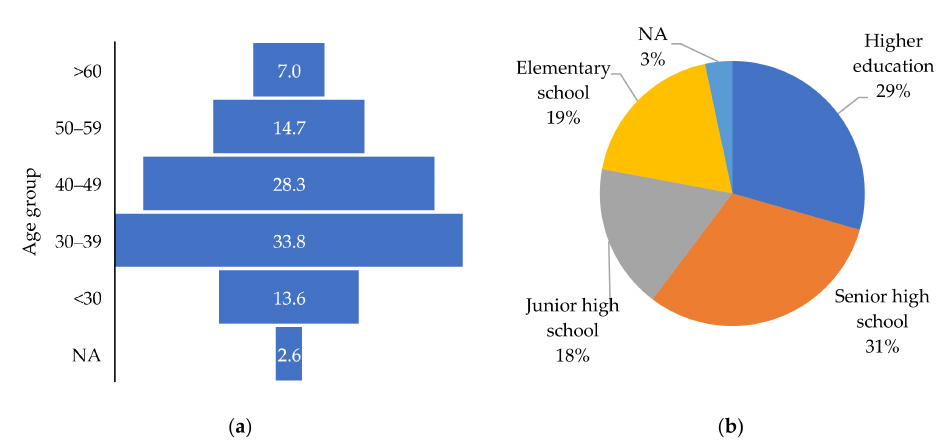
Figure 2. Profile of beekeepers based on ( a ) age groups and ( b ) educational background.